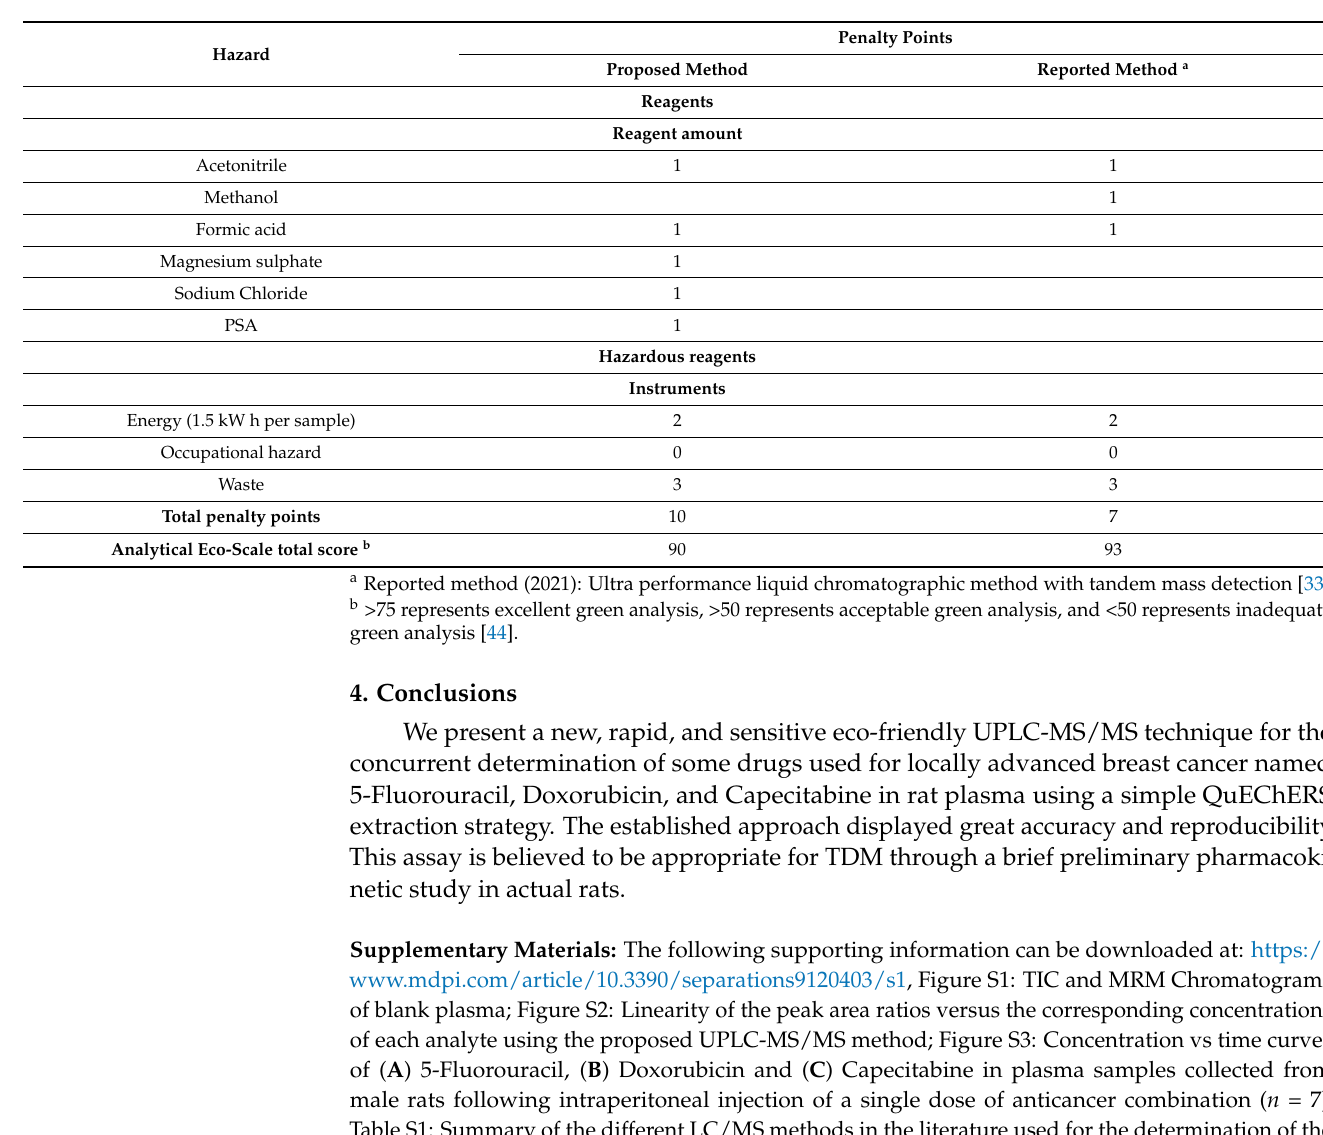
Table S1: Summary of the different LC/MS methods in the literature used for the determination of the studied compounds in biological samples; Table S2: Comparison between the proposed method and the other reported method [11]; Table S3: Accuracy, Intra and inter-day precision data in rat plasma at three concentration levels ( n = 15). References 46–55 are cited in the supplementary material